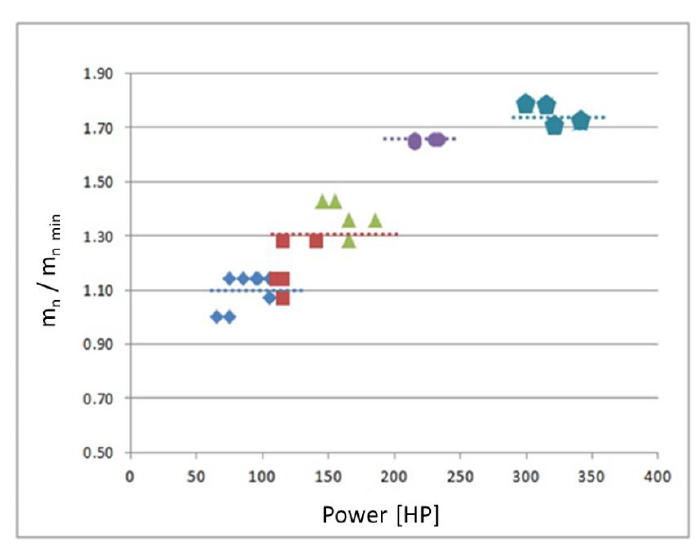
Figure 11. Gear modules for the final reduction DA.